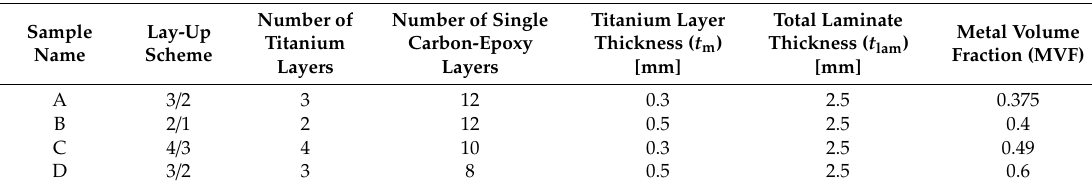
Table 1. HTCL composite laminates details.